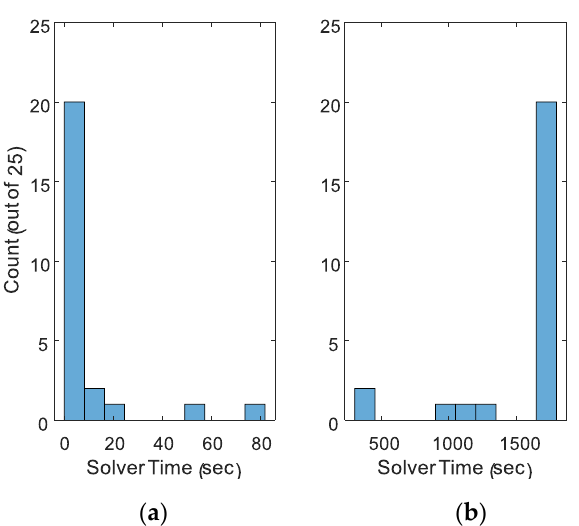
Figure 7. Histogram of IPOPT solver time for the small ( a ) and the large ( b ) problems.